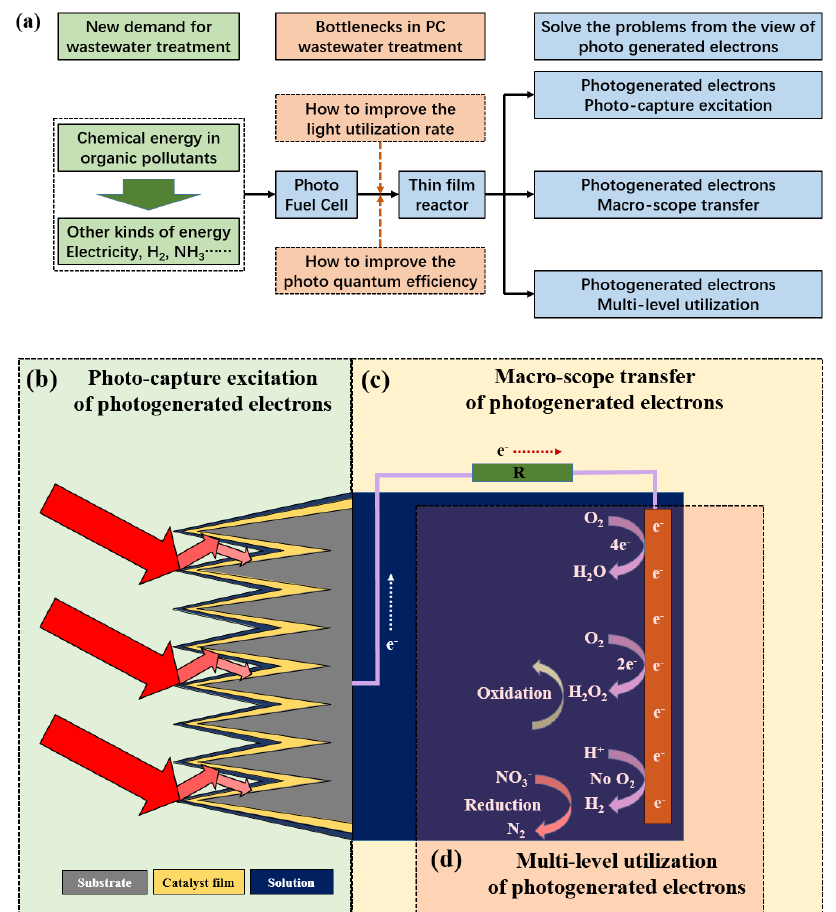
Figure 2. ( a ) New demand for water treatment, bottlenecks in photocatalytic (PC) wastewater treat- ment and the corresponding solutions, including ( b ) light − harvesting excitation, ( c ) macro − scope − harvesting excitation, ( c ) macro − scope transfer, and ( d ) multi − level utilization of photogenerated electrons. ment and the corresponding solutions, including ( b ) light transfer, and ( d ) multi − level utilization of photogenerated